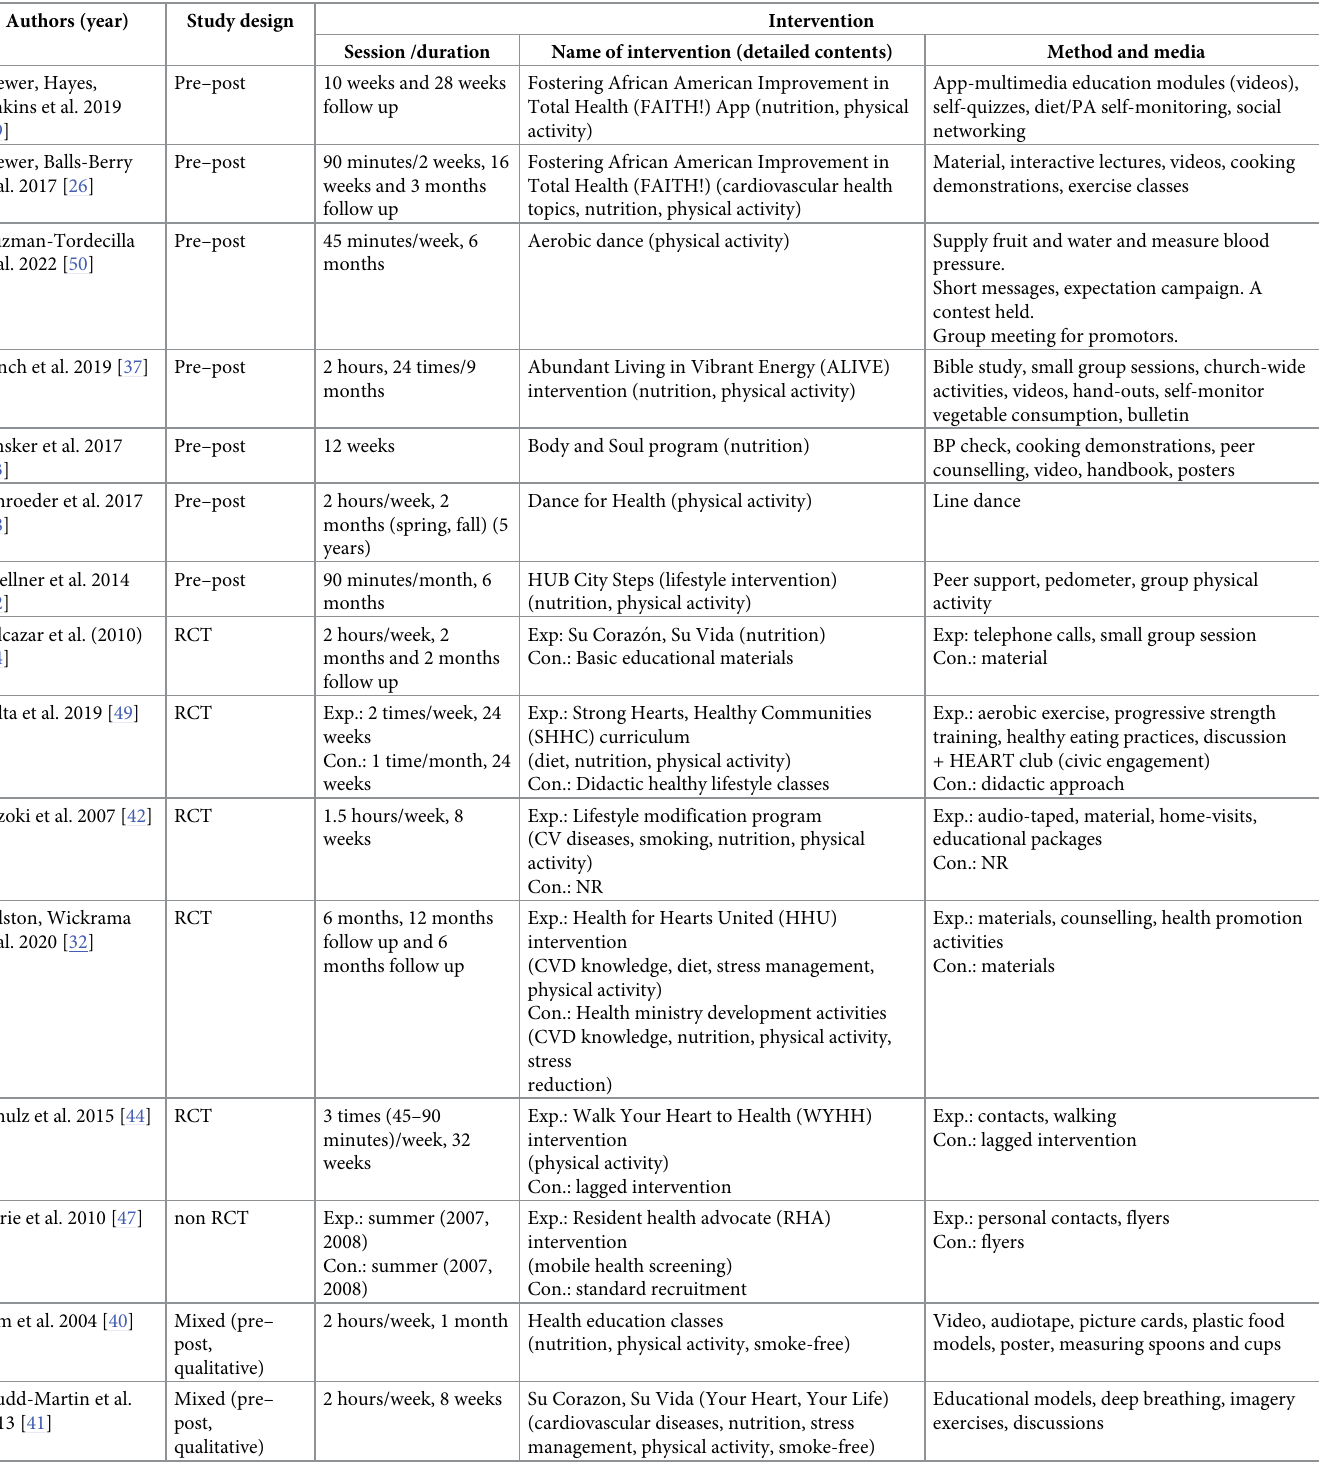
Table 5. The details of CVD management program based on